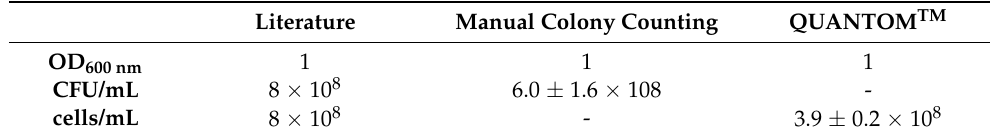
Table 2. E. coli wildtype cell counts as obtained by indicated